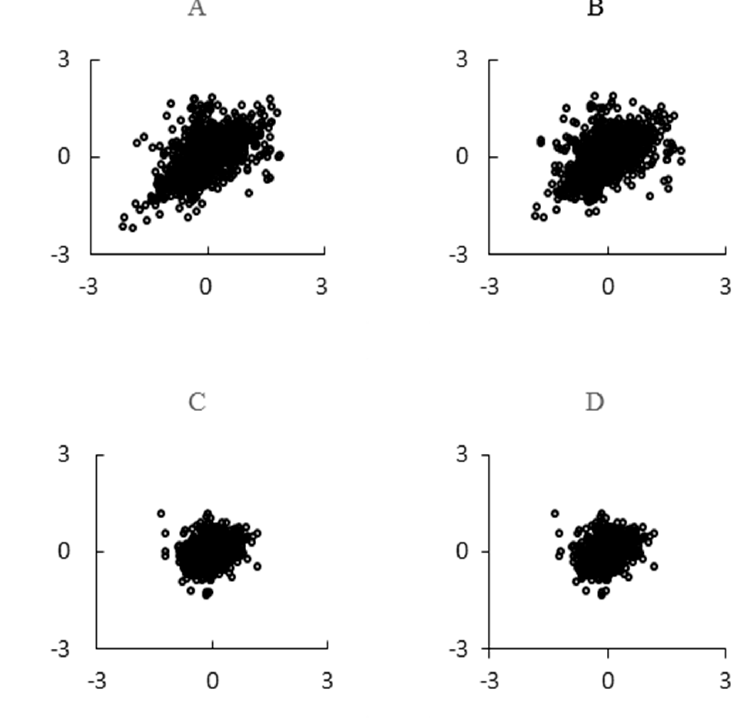
Figure 2. Diameter residuals plotted against Lag1—residuals for Kozak [1] fitted. ( A ): Ordinary nonlinear least squares; ( B ): Plot-level effects; ( C ): Tree-level effects; ( D ): Nested effects of plot and tree.